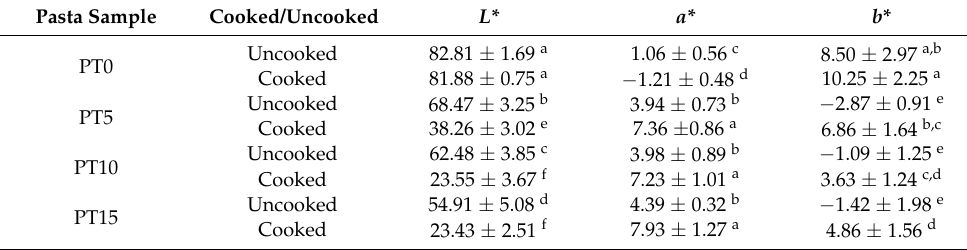
Values with different superscripts within the same column are significantly different for p < 0.05. PT0: pasta formulated with 100% durum wheat semolina. PT5, PT10, PT15: 95:5, 90:10, 85:15 durum wheat semolina:DTP,